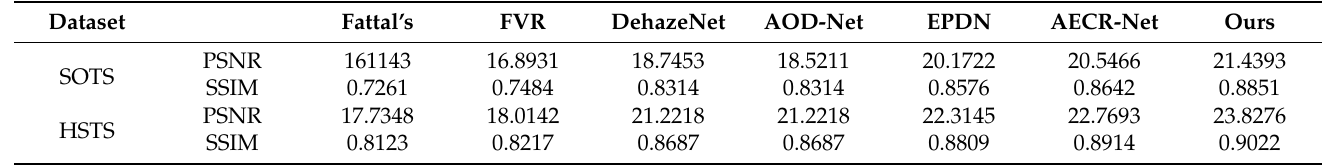
Table 2. Average PSNR/SSIM of dehazed results on the SOTS and HSTS